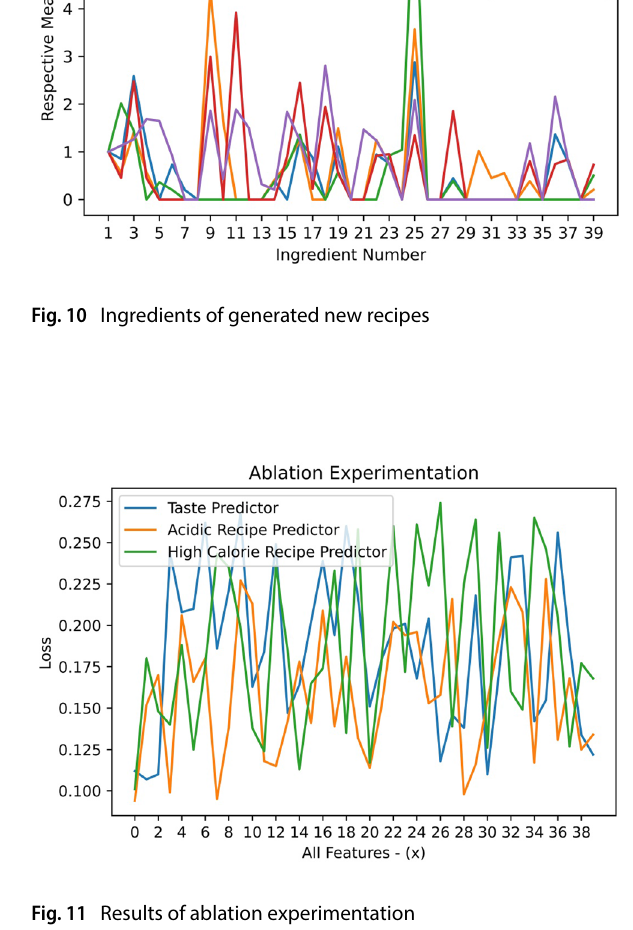
Fig. 11 Results of ablation